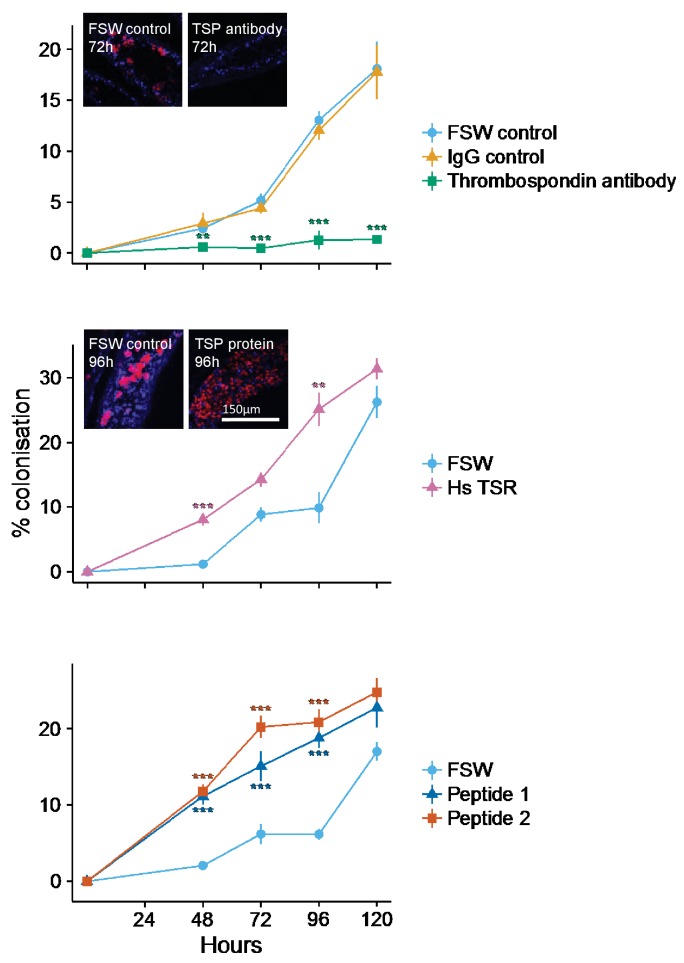
Kinetics of recolonization after antibody and peptide treatments.(A) Anemones pre-incubated in an anti-human thrombospondin (green) show decreased colonization success compared FSW-only (light blue) and IgG (orange) controls. Inset: confocal images show representative tentacle slices at 72 hr post-inoculation. (B) The addition of exogenous human thrombospondin-1 (purple) significantly increased the colonization rate during colonization, compared to control anemones in FSW (blue). Inset confocal images show representative tentacle slices at 96 hr post-inoculation. (C) The effect of synthetic TSR peptides 1 (blue) and 2 (orange) on colonization rates compared to the control anemones in FSW. Anemones treated with both peptides 1 and 2 showed increased uptake of algae during colonization. Statistical significance of treatment effects was assessed using mixed effects models, with contrasts calculated between individual treatments and FSW at each time-point; ***p<0.001; *p<0.05; p<0.1.DOI:
http://dx.doi.org/10.7554/eLife.24494.01110.7554/eLife.24494.012Figure 5—source data 1.Source data used for statistical analyses described in results and depicted in Figure 5A: Long-form table with experimental results described in the results section Blocking TSR domains inhibits symbiont uptake by host anemones and shown in Figure 5A.Treatments labels are FSW: Filtered Sea Water, anti-TSR: anti-human thrombospondin antibody, Igg: IgG control.DOI:
http://dx.doi.org/10.7554/eLife.24494.01210.7554/eLife.24494.013Figure 5—source data 2.Summary statistics (mean and s.e.) displayed in Figure 5A.Summary statistics for results in section Blocking TSR domains inhibits symbiont uptake by host anemones as shown in Figure 5A.DOI:
http://dx.doi.org/10.7554/eLife.24494.01310.7554/eLife.24494.014Figure 5—source data 3.Source data used for statistical analyses described in results and depicted in Figure 5B.Long-form table with experimental results described in the results section Addition of exogenous human thrombospondin-1 results in ‘super colonization’ of hosts by symbionts and shown in Figure 5B. Treatments labels are FSW: Filtered Sea Water, Hs-TSR: Homo sapiens exogenous TSR protein treatment.DOI:
http://dx.doi.org/10.7554/eLife.24494.01410.7554/eLife.24494.015Figure 5—source data 4.Summary statistics (mean and s.e.) displayed in Figure 5B.Summary statistics for results in section Addition of exogenous human thrombospondin-1 results in ‘super colonization’ of hosts by symbionts as shown in Figure 5B.DOI:
http://dx.doi.org/10.7554/eLife.24494.01510.7554/eLife.24494.016Figure 5—source data 5.Source data used for statistical analyses described in results and depicted in Figure 5C.Long-form table with experimental results described in the results section Addition of exogenous A. pallida TSR peptide fragments during inoculation increases colonization success and shown in Figure 5C.DOI:
http://dx.doi.org/10.7554/eLife.24494.01610.7554/eLife.24494.017Figure 5—source data 6.Summary statistics (mean and s.e.) displayed in Figure 5C.Summary statistics for results in section Addition of exogenous A. pallida TSR peptide fragments during inoculation increases colonization success as shown in Figure 5C.